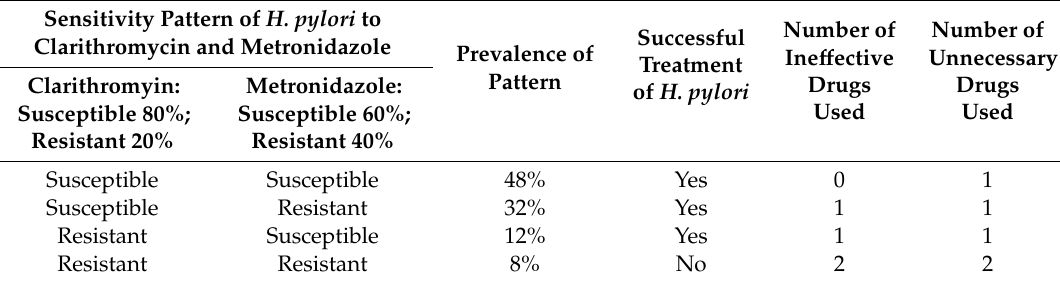
Legend: Table showing the number of ine ff ective or unnecessary antibiotics used by a population of patients similar to those seen in Texas with the H. pylori resistance pattern of 20% resistant to clarithromycin, 40% resistant to metronidazole (8% dual resistance) which receives concomitant therapy with a PPI, amoxicillin, clarithromycin, and metronidazole. From [69] with